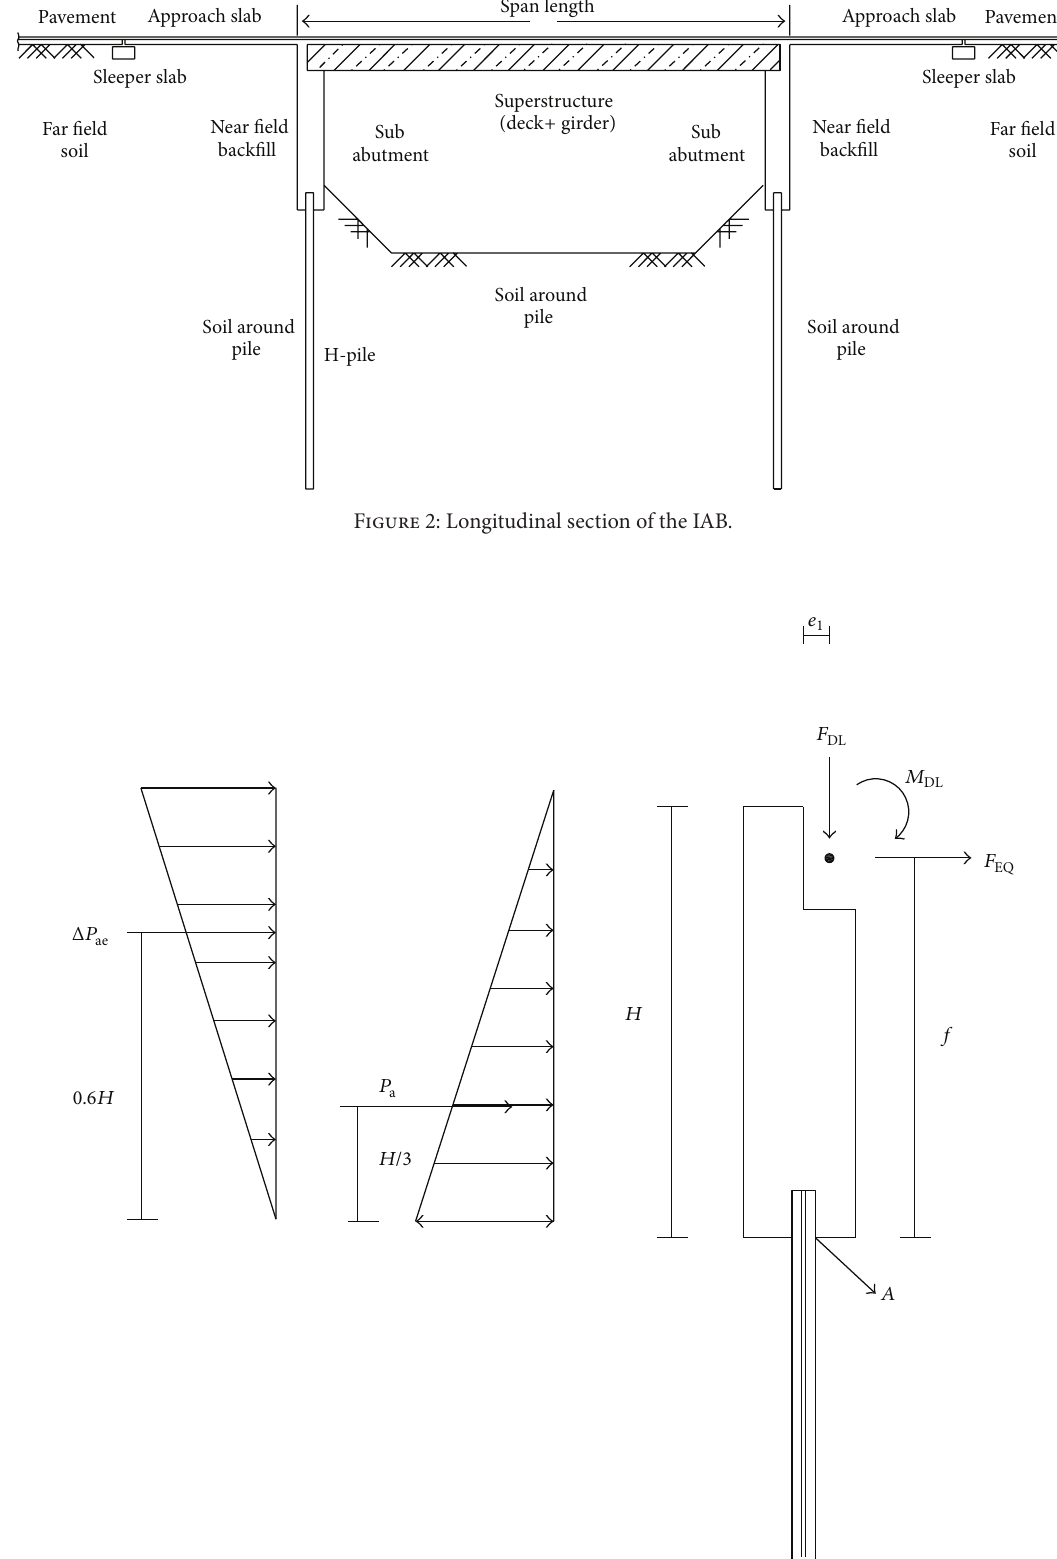
Figure 3: Free body diagram of IAB pile, dominant failure is bending at point 𝐴